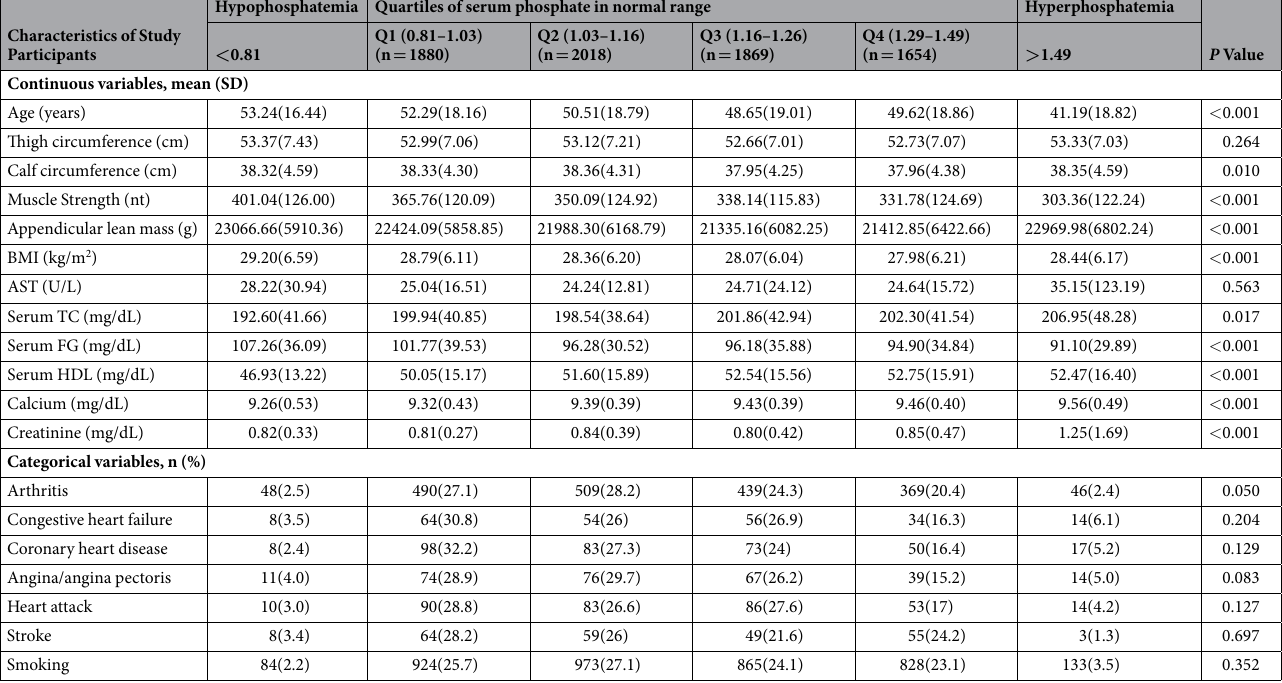
Table 2. Characteristics of study participants of quartiles of serum phosphate. BMI, body mass index; SBP, systolic blood pressure; Serum FG, serum fasting glucose; Serum TC, serum total cholesterol; AST, aspartate aminotransferase; Serum HDL, serum high density lipoprotein. a Values were expressed as mean (standard deviation). b Values in the categorical variables were expressed as number